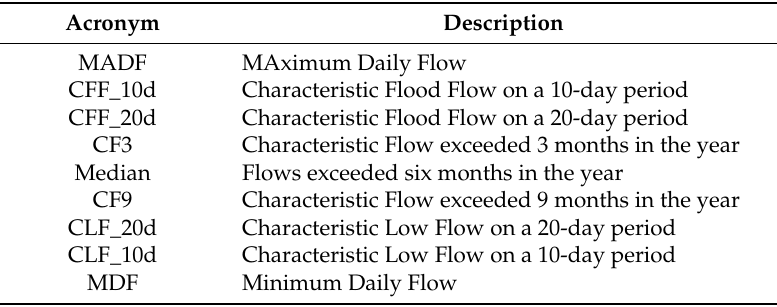
Table 4. Characteristics flow rates